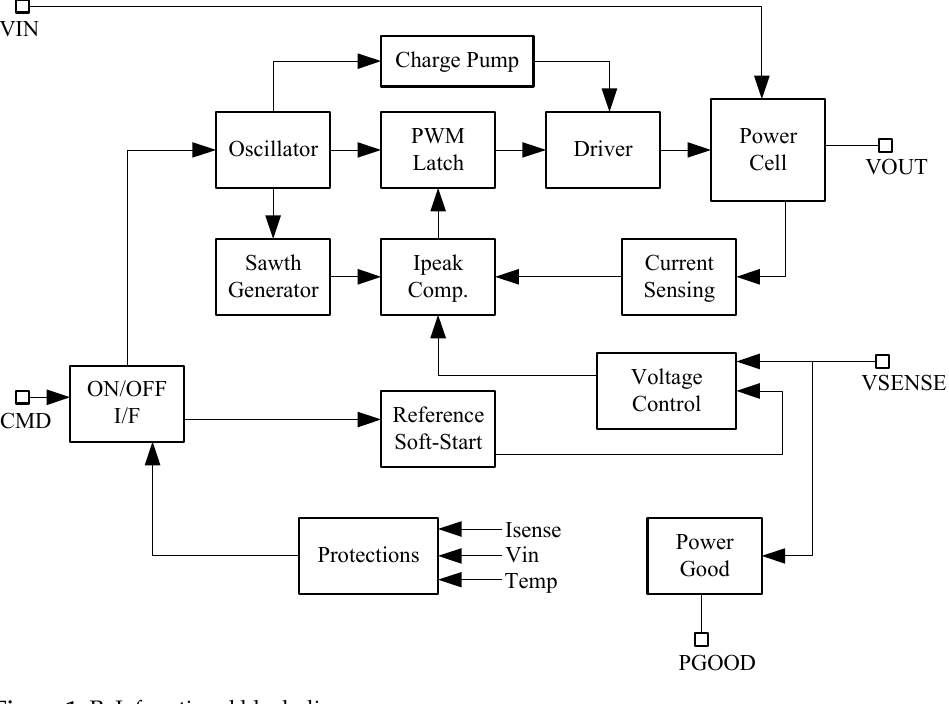
Figure 1. PoL functional block diagram.